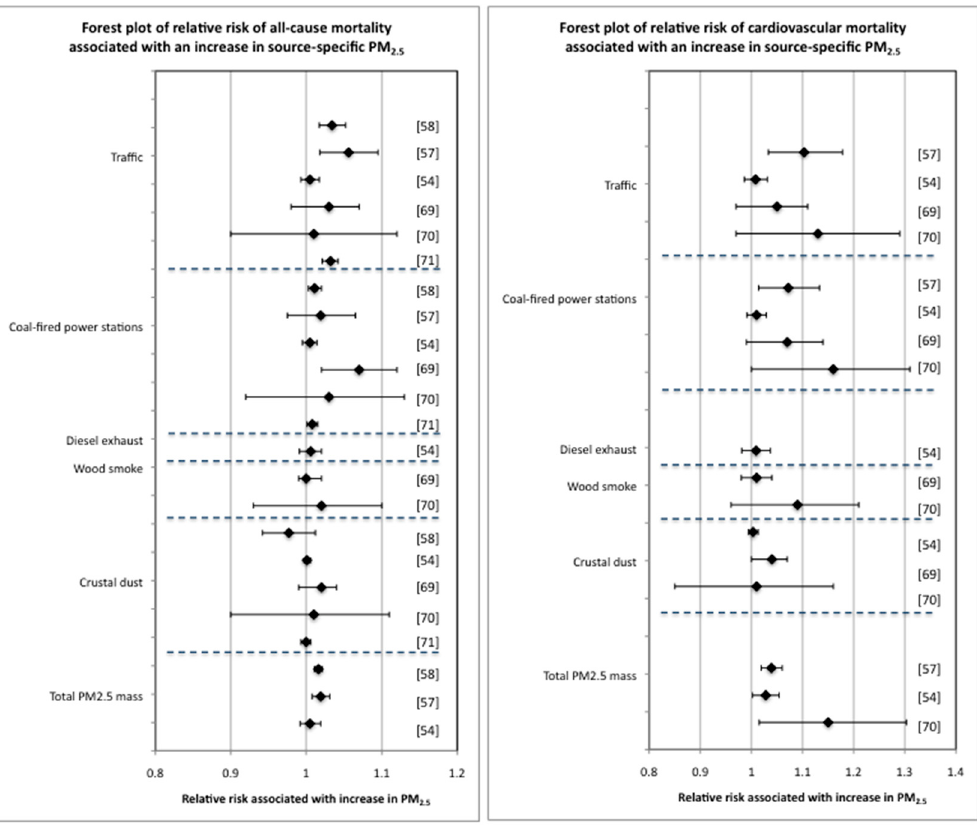
Figure 2. Forest plots of the change in all-cause and cardiovascular risk associated with increases in source-specific PM 2.5. The data in these forest plots are from Table 2. The reference numbers applicable to the different data are shown.